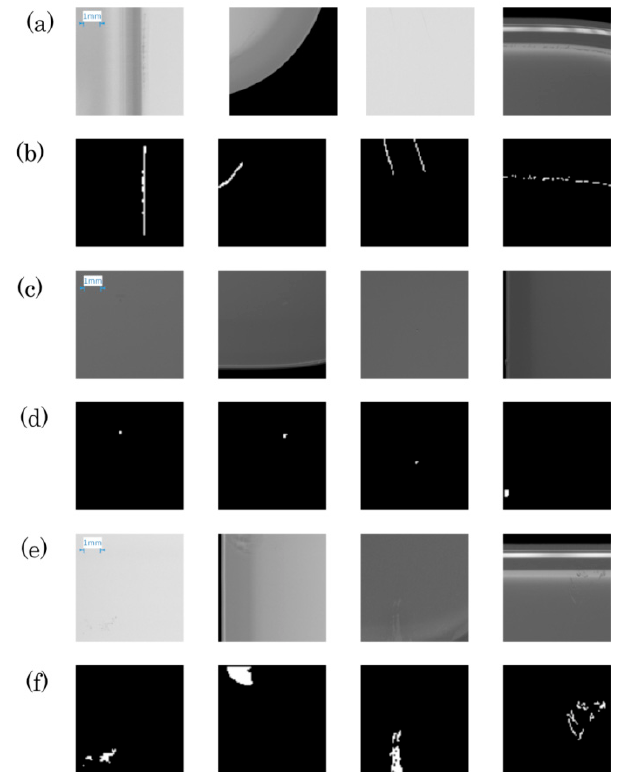
Figure 5. Typical defect samples and corresponding ground truth defect images: ( a , b ) are respectively scratch defects and the corresponding ground truth annotations; ( c , d ) are respectively dent defects and the corresponding ground truth annotations; ( e , f ) are respectively discoloration defects and the corresponding ground truth